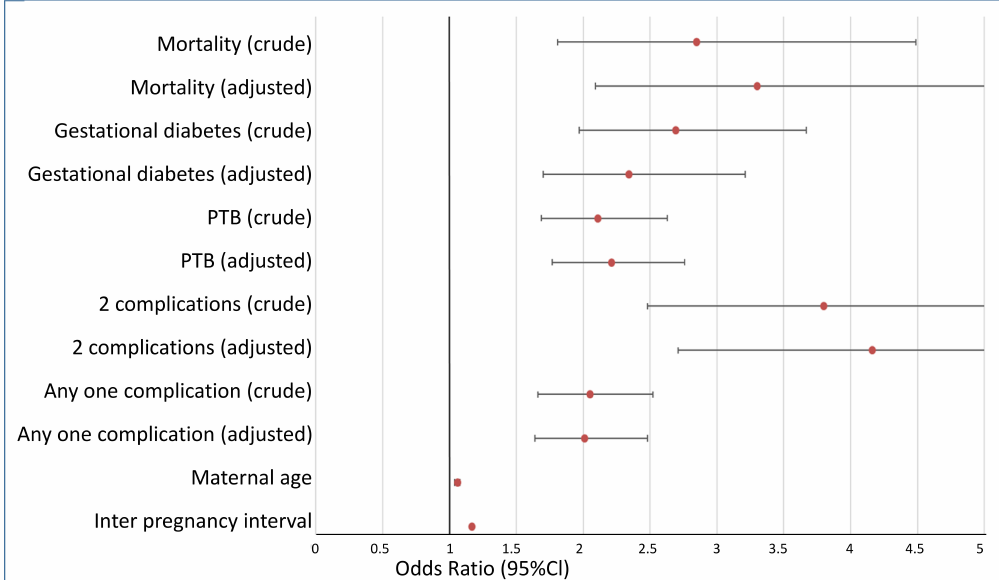
Figure 1. Adjusted (for maternal age and inter-pregnancy interval) and unadjusted odds ratios for the associations between first pregnancy complications and preeclampsia in subsequent pregnancy.